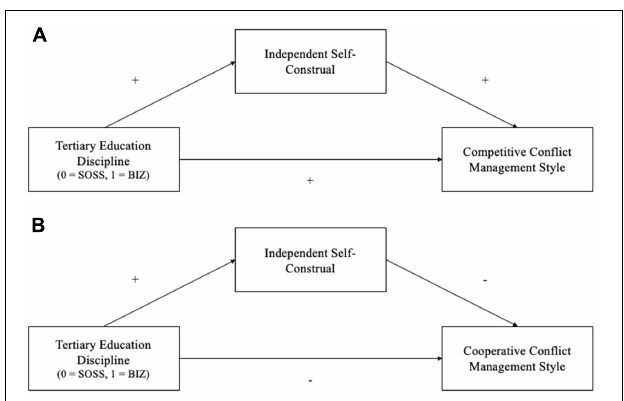
FIGURE 1 | Hypothesized mediation models with independent self-construal as the mediator for tertiary education discipline and competitive conflict management style (H6) in panel (A) , and cooperative conflict management style (H7) in panel (B) . SOSS and BiZ refers to social science and business discipline